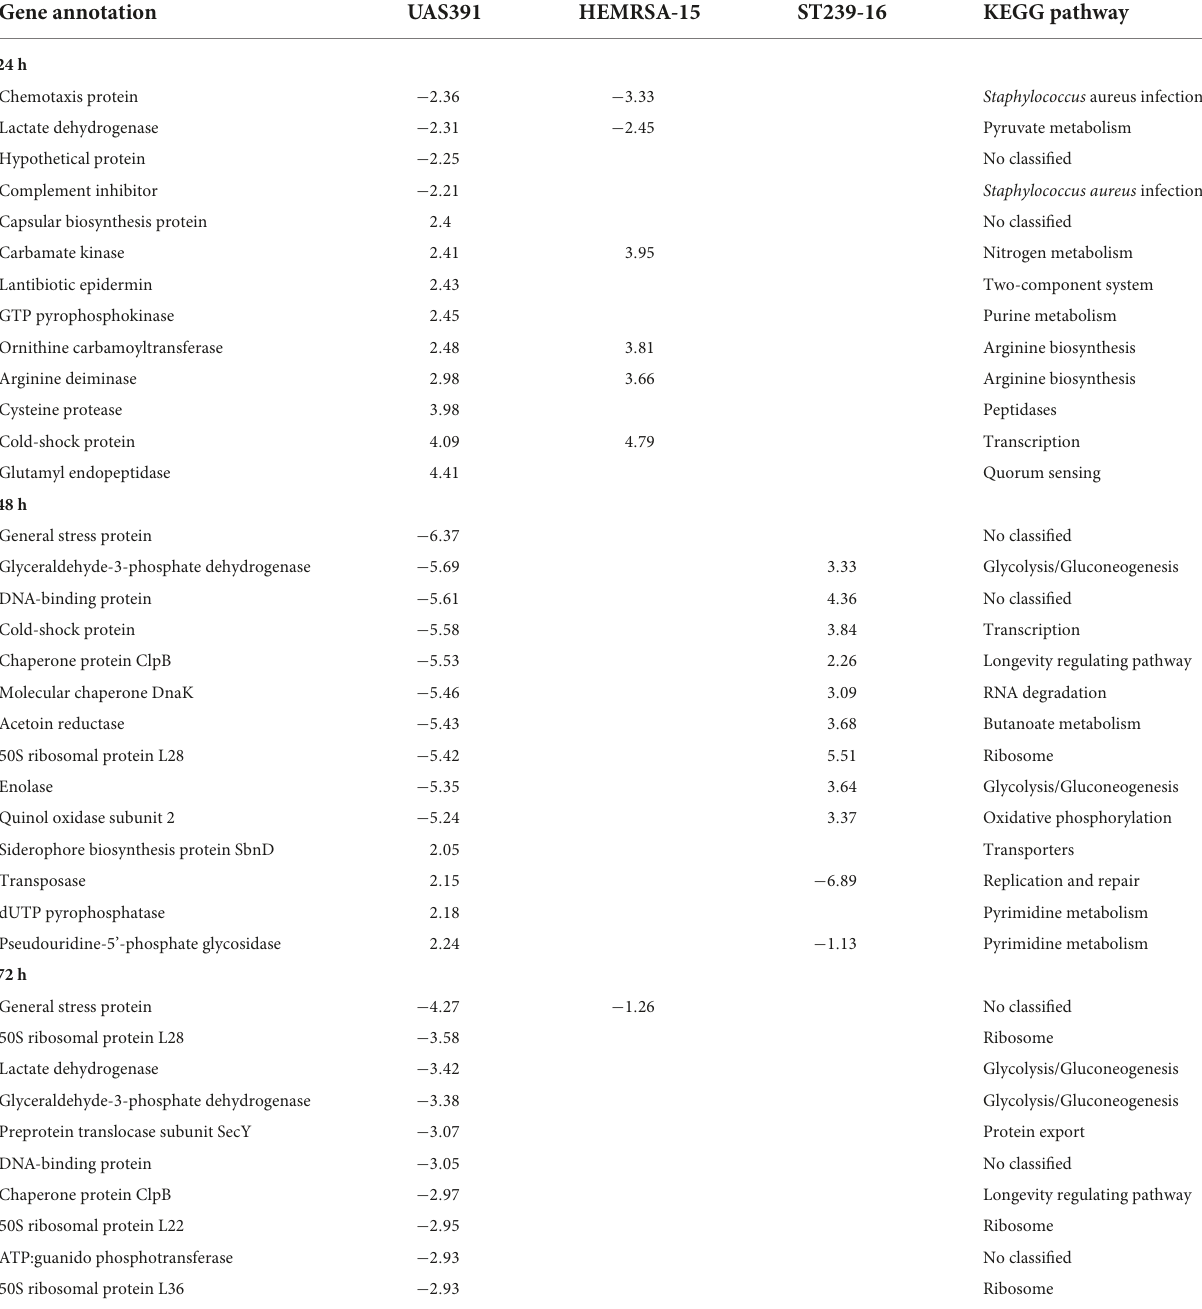
TABLE 1 Top differentially expressed genes (up and down) with |log 2 (fold change)| ≥ 1 and adjusted p -value < 0.05 in biofilms compared to the planktonic phenotype after 24 h of growth of UAS391, HEMRSA-15, and